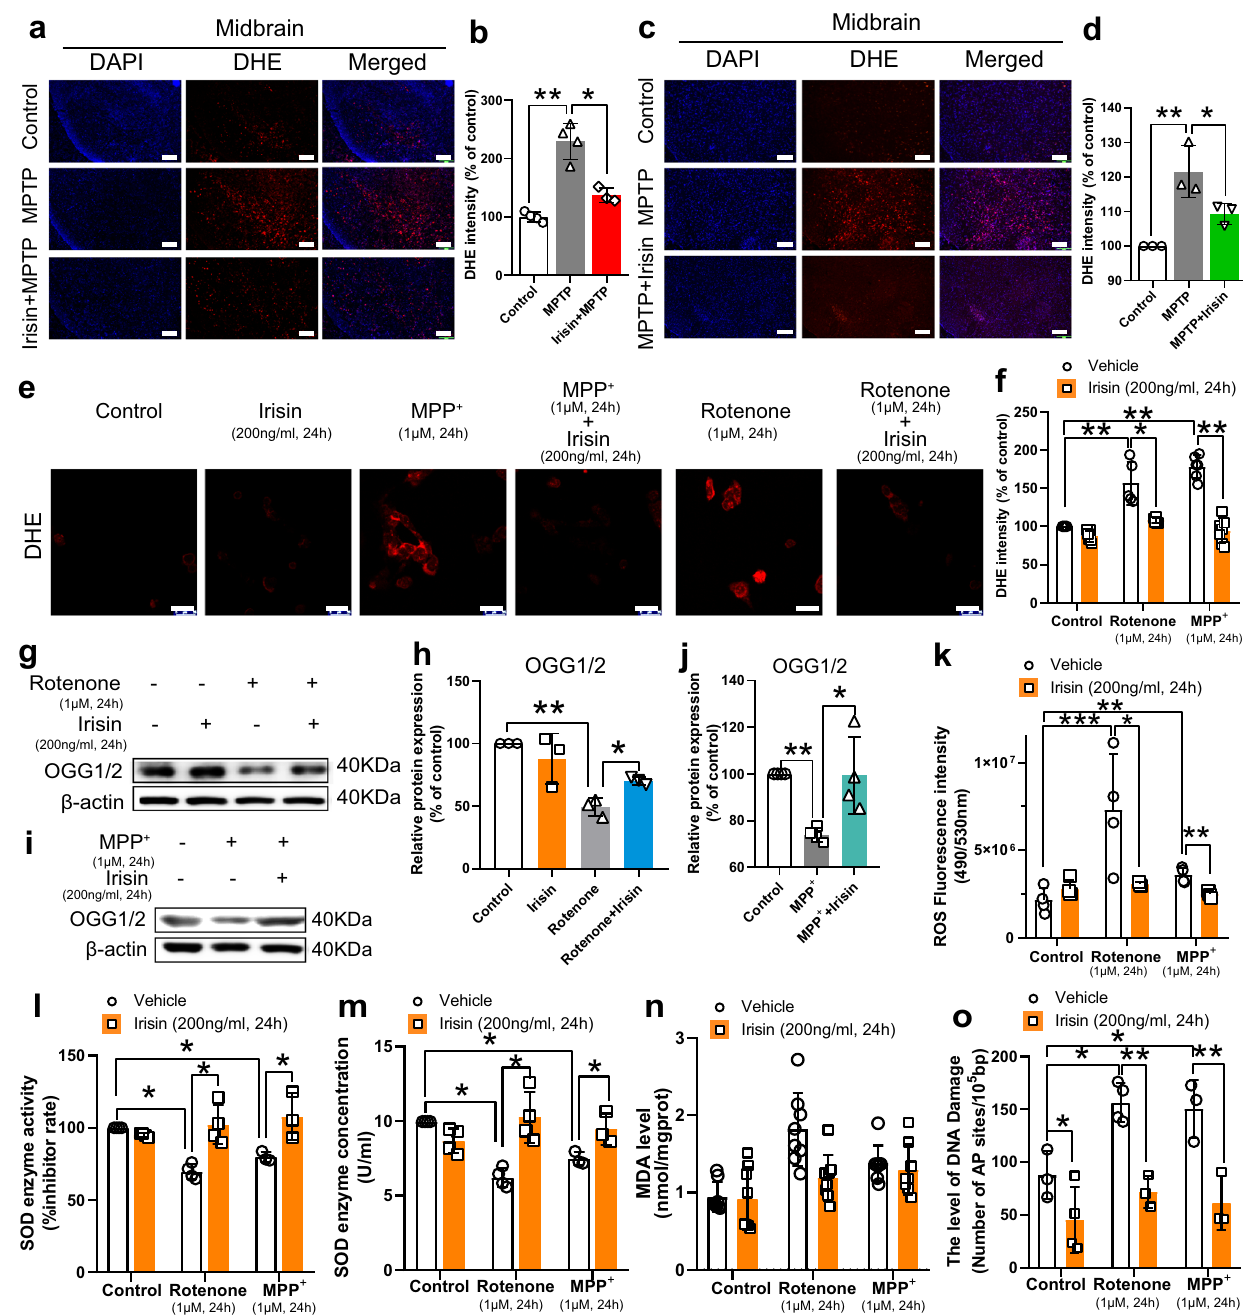
Fig. 3 Irisin decreases oxidative stress in PD models induced by neurotoxins. a , b DHE fl uorescence staining and its fl uorescence intensity in midbrain of MPTP treated mice receiving pre-treatment with irisin. Scale bar, 200 μ m. c , d DHE fl uorescence staining and its fl uorescence intensity in midbrain of MPTP treated mice receiving delayed treatment with irisin. Scale bar, 200 μ m. e , f DHE fl uorescence staining and its fl uorescence intensity in various groups of in vitro experiments. Scale bar, 30 μ m. g , h Western blot showing the quanti fi cation of OGG1/2 in SH-SY5Y cells treated with irisin and MPP + . i , j Western blot showing the quanti fi cation of OGG1/2 in SH-SY5Y cells treated with irisin and rotenone. k DCFH-DA assay showing ROS level in various groups of in vitro experiments. l , m SOD enzyme activity and SOD enzyme concentration in various groups of in vitro experiments. n MDA level in various groups of in vitro experiments. o The level of AP sites showing the level of DNA damage in various groups of in vitro experiments. All data are presented as mean ± SEM ( n ≥ 3). ∗ p <0.05, ∗∗ p <0.01, and ∗∗∗ p